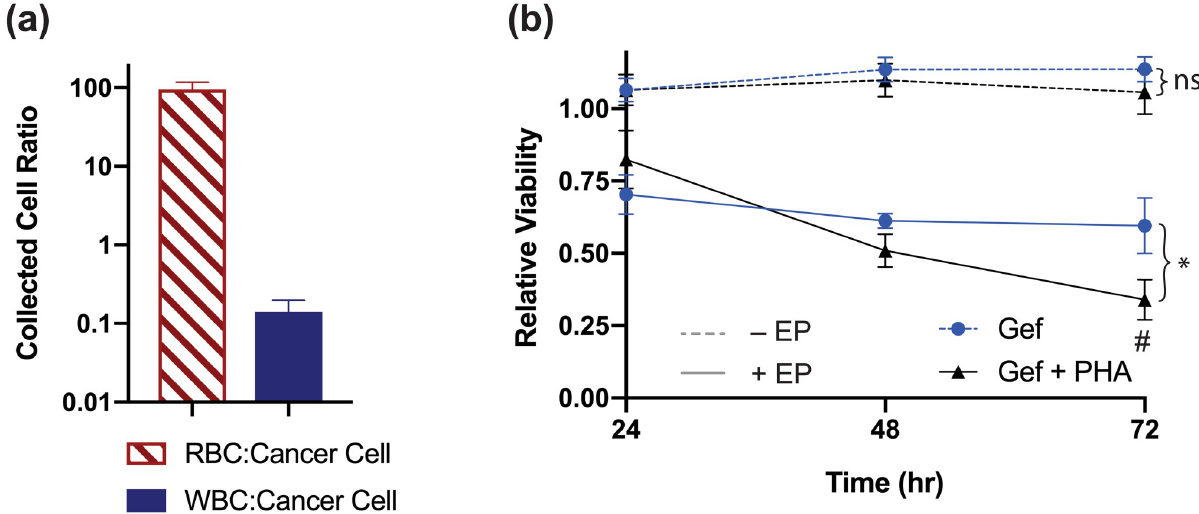
Fig 4. Spiked blood sample purity assessment and drug response curve. Spiked cancer cells (HCC827 GR6) were isolated from the blood and subsequently electroporated for drug combination testing. (a) Purity of isolated cancer cells (expressed in ratios relative to WBC and RBC counts). The number of contaminant blood-borne cells was deemed insignificant for interfering with luminescence assay. Error bars represent standard error of mean (n = 24) (b) Viability response of HCC827 GR6 after electroporation in gefitinib solution (100 nM) or a sequential combination of both (PHA- 665752, 20 nM) at time points 24, 48, and 72 hrs (solid line). Control experiments without electroporation step during drug solution incubation are shown with dashed lines (100 and 20 pmol for gefitinib and PHA-665752, respectively). Shown viability% is normalized by the luminescence intensity of untreated (DPBS) control cells in their respective condition. Error bars represent the standard error of the mean (n = 3). � p < 0.1 vs gefitinib (electroporation) groups. #p < 0.1 vs gefitinib + PHA-665752 (- EP) groups.